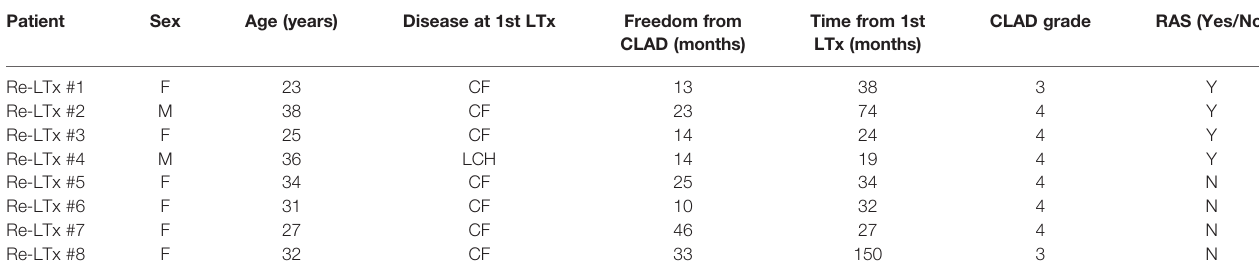
TABLE 1 | Clinical characteristics of lung re-transplant recipients 1